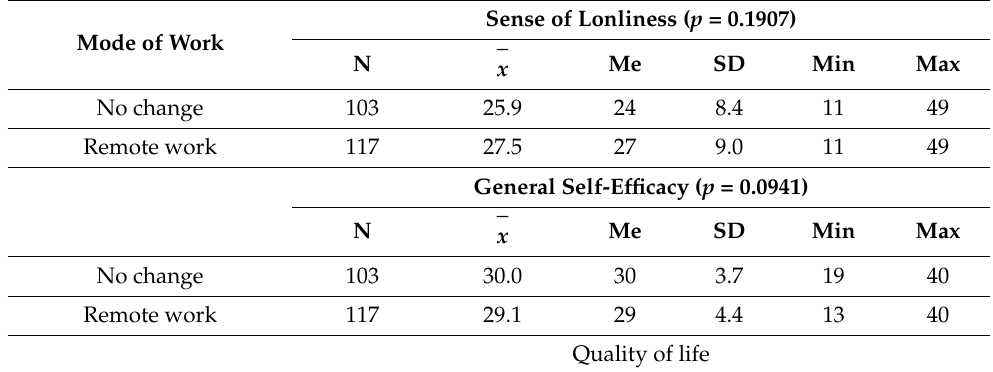
Table 7. A sense of loneliness and self-efficacy in connection with the mode of work performed. Sense of Lonliness ( p = Mode of Work